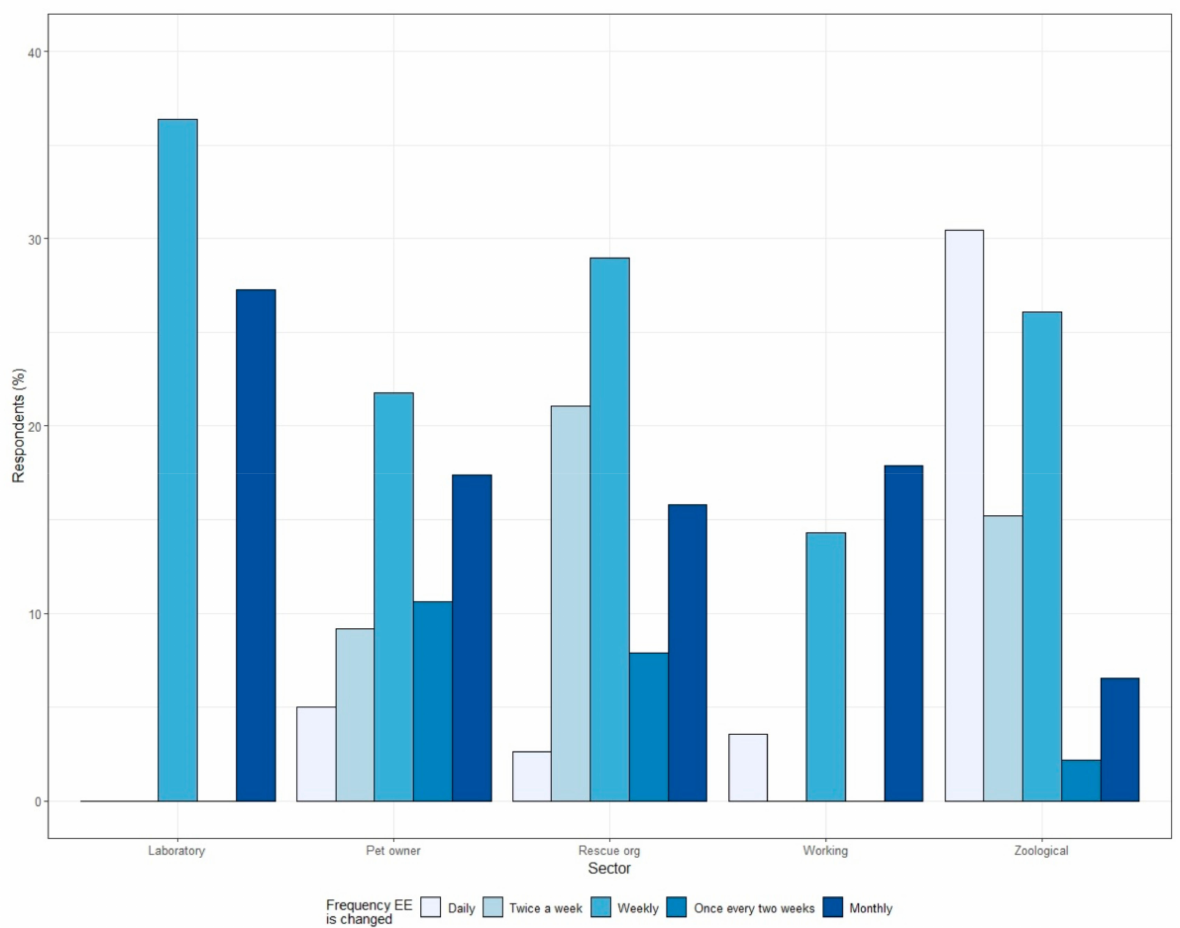
Figure 3. Frequency that respondents from different caretaker sectors reported changing EE items provided to their